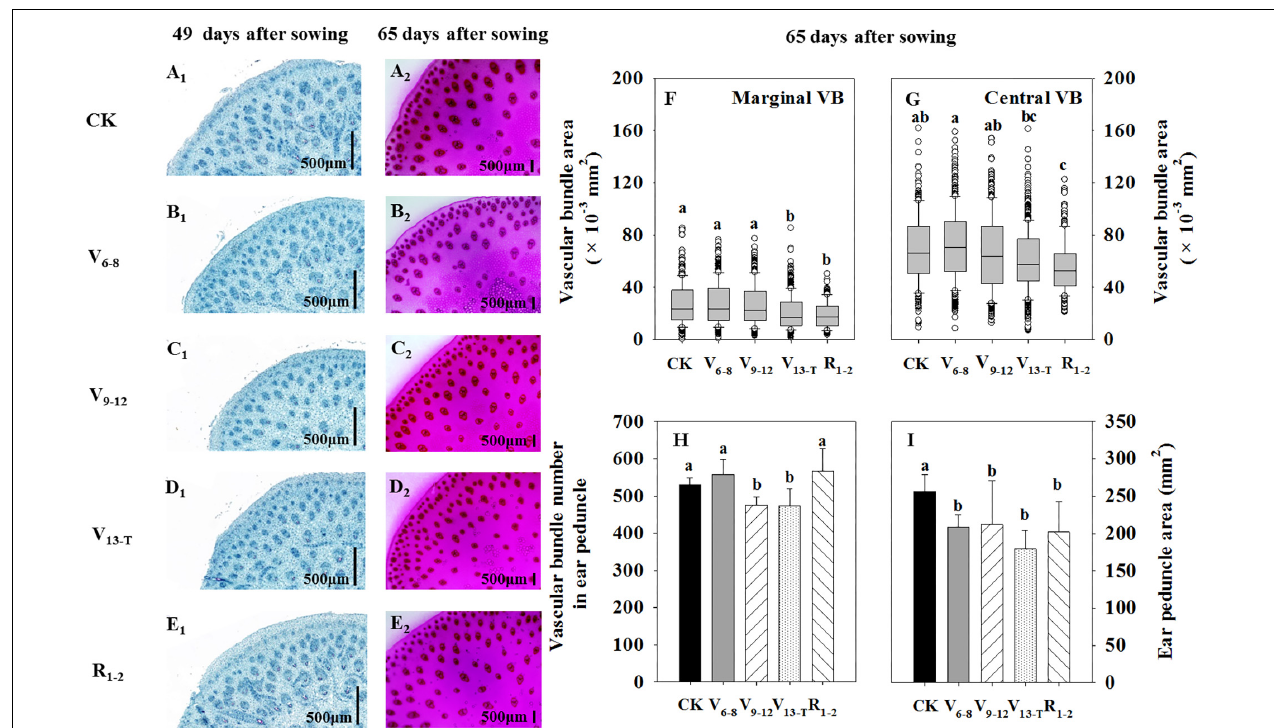
FIGURE 3 | Transverse section of ear peduncle at 49 (A 1 –E 1 ) and 65 (A 2 –E 2 ) days after sowing (DAS); the area of the marginal vascular bundle (VB) (F) and central VB (G) ; and the total vascular bundle number in ear peduncle (H) and ear peduncle area (I) at 65 DAS (12 days after silking). The marginal VB, closely arranged at the edge of the ear peduncle, was consistently undeveloped and was small in size. The central VB, scattered and distributed in the center of the ear peduncle, was consistently well-developed and had a large size. CK, well-irrigated treatment; V 6 − 8 , water deficit during the 6–8-leaf stage; V 9 − 12 , water deficit during the 9–12-leaf stage; V 13 − T , water deficit from the 13-leaf stage to tasseling stage, R 1 − 2 , water deficit from the silking stage to blister stage. Values with different letters are significantly different at P < 0.05.